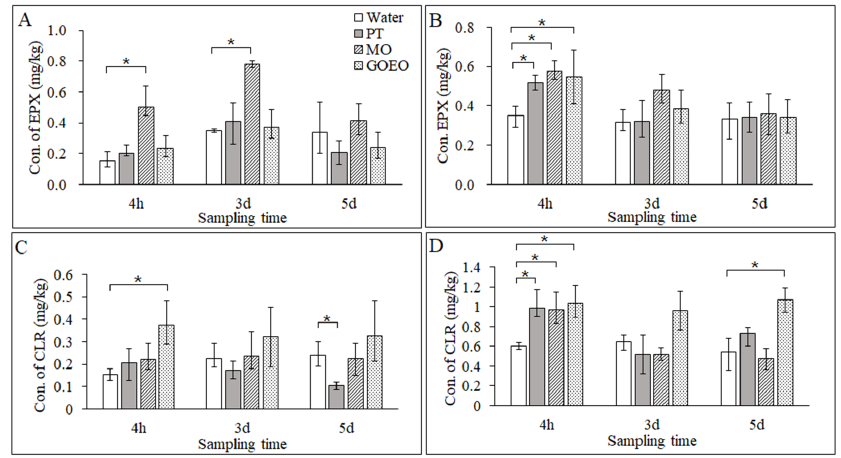
Figure 4. The concentrations of EPX and CLR in rice shoots: ( A ) EPX at 125 mg/L, ( B ) EPX at 187 mg/L, ( C ) CLR at 66.7 mg/L, and ( D ) CLR at 100 mg/L. * p < 0.05.